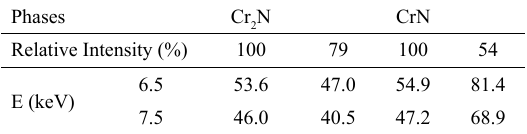
Table 6. Positions of diffracted angles for chromium nitrides.